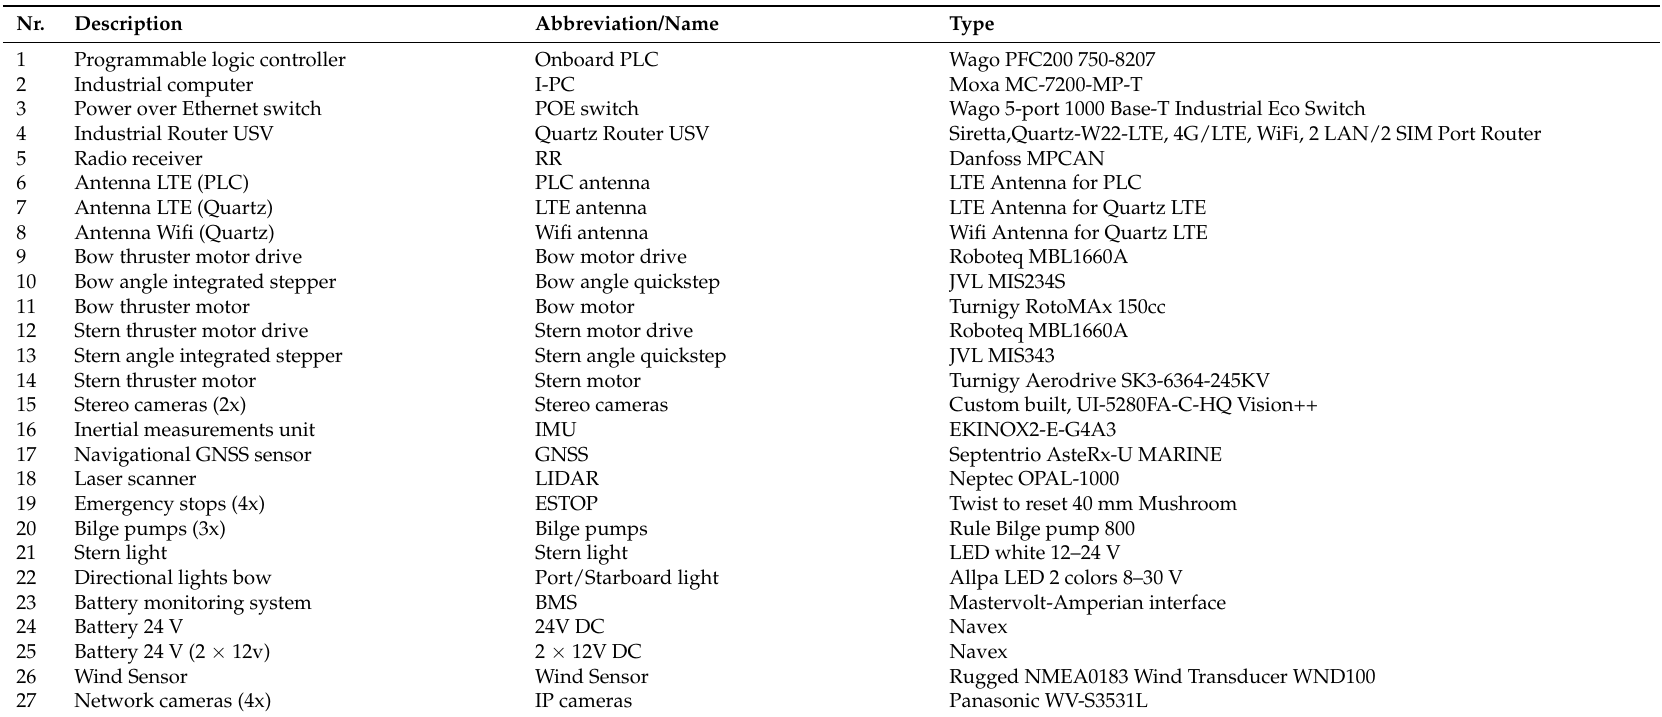
Table A1. List of extended I-SCC and USV system components: their descriptions, abbreviations or names, and specific types.